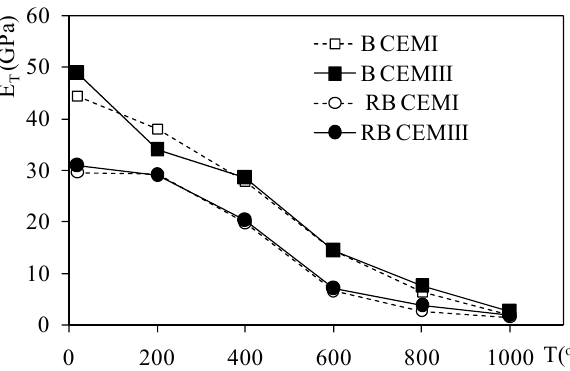
Figure 6. Modulus of elasticity change with the temperature of CEMI and CEMIII concretes.